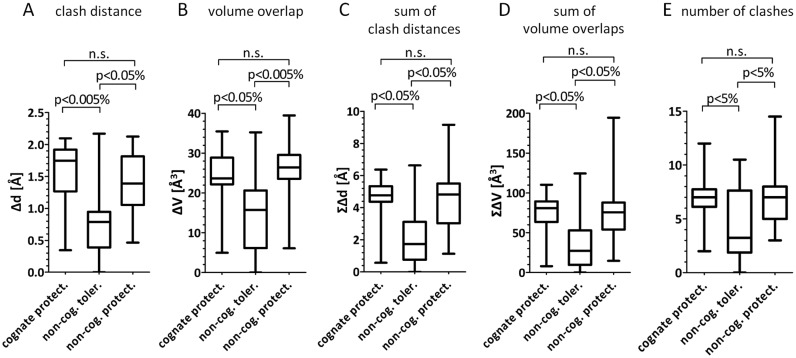
Analysis of the severity of clashes in case of cognate protective, non-cognate tolerated and non-cognate protective methylation. P-values are based on Wilcoxon rank sum test; n.s.—non-significant difference. Whiskers show min and max values. Horizontal bars represent median.